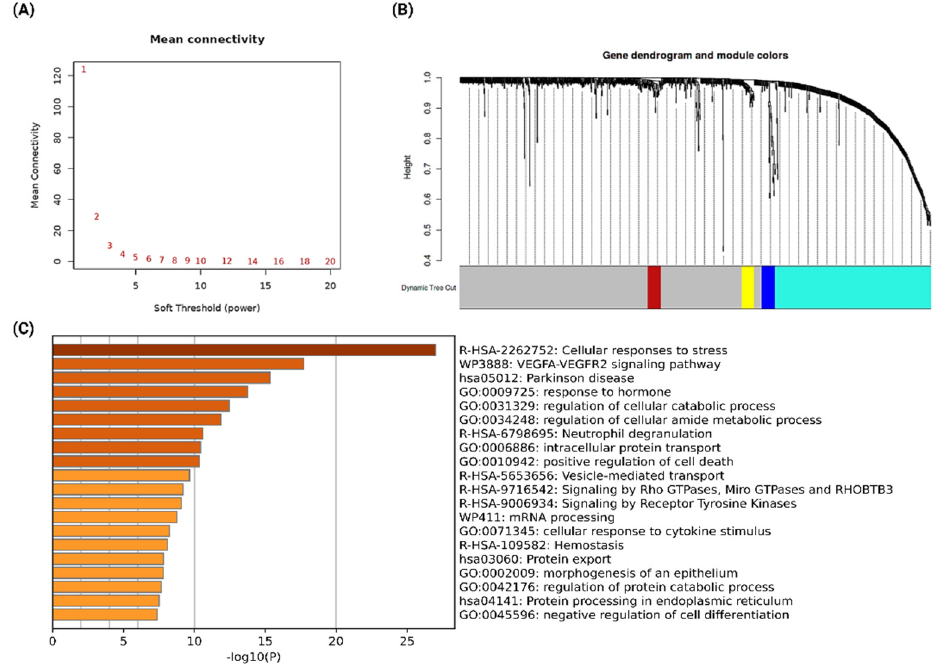
Figure 2. ( A ) Scale independence and mean connectivity of various soft-thresholding values ( β ). ( B ) Hierarchical clustering dendrograms of identified modules of co-expressed differentially expressed genes in NAC-resistant breast cancer patients. Four co-expression modules were detected and are colored blue, brown, yellow, and turquoise. ( C ) Enriched biological processes and pathways of the genes from the turquoise module. Bar graph of enriched terms across input gene lists, colored by p - values. The graph was prepared using Metascape.